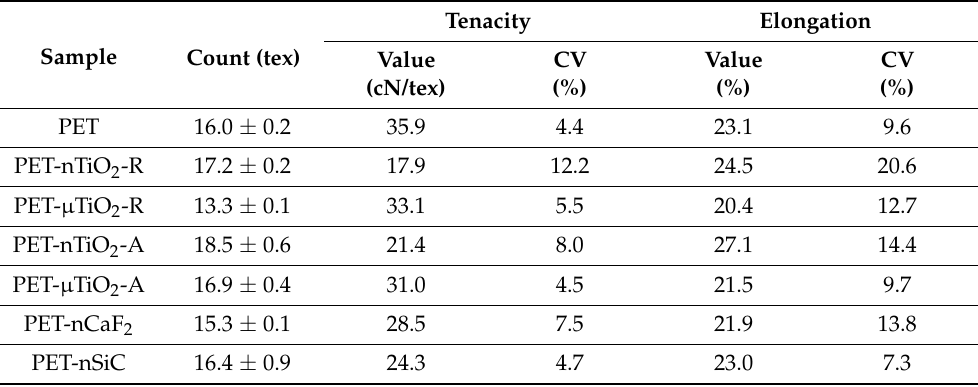
Table 4. Yarns count, tenacity, and elongation before exposure to the climatic